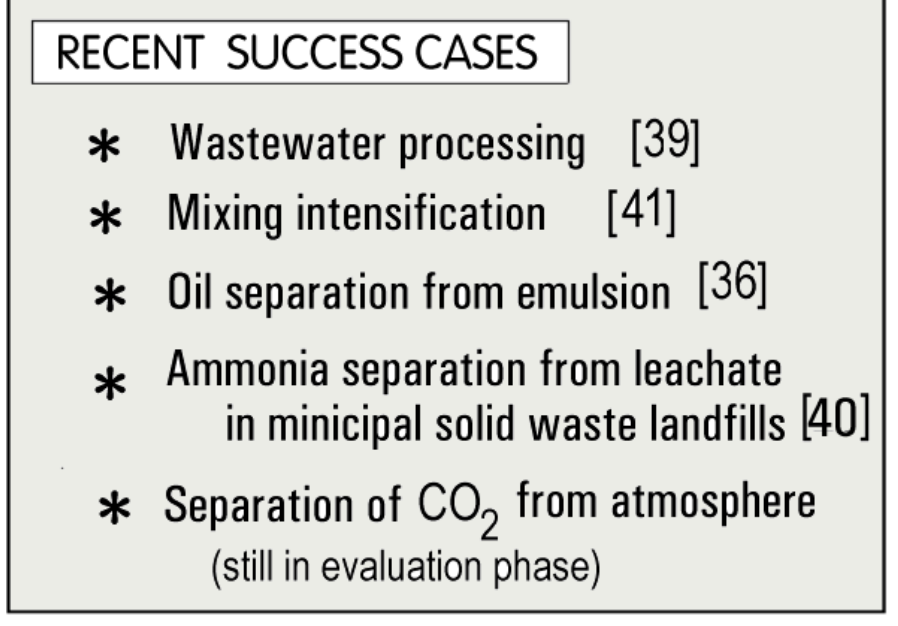
Figure 11. Using the T-Z oscillator has already made possible several successful solutions of important tasks, mainly in the field of biotechnology. The supplied air flow agitation by fluidic oscillator was the key factor in its success [25–29].